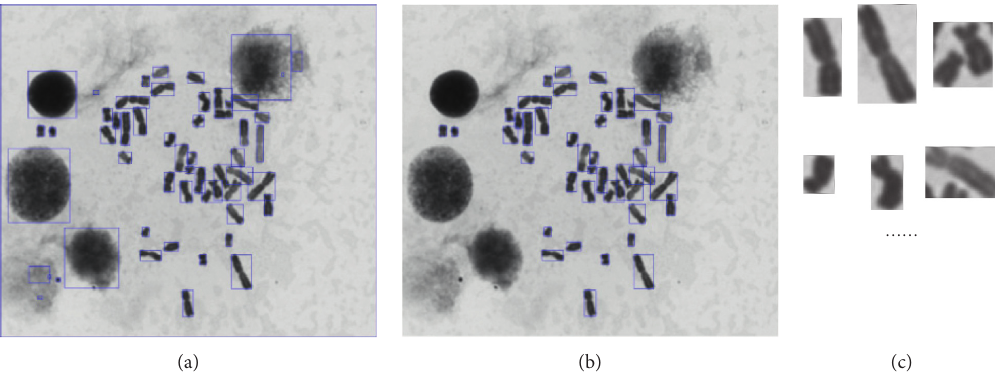
Figure 5: Results for candidate chromosome detection: (a) ER detection results with quantity of misclassifies, (b) chromosome candidates after geometric and intensity invariance filters, and (c) to the final results for chromosome